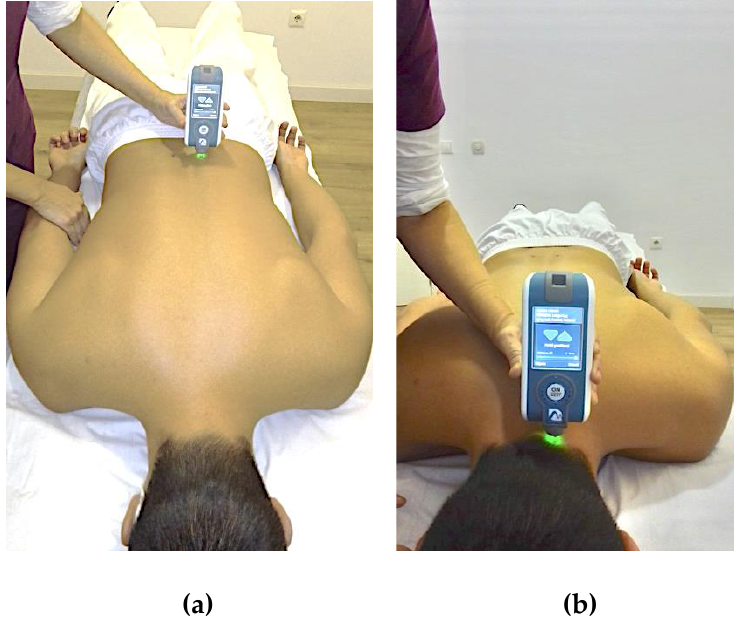
Figure 1. Assessment of muscle mechanical properties (MMPs). ( a ) Lumbar myotonometry. Subject position and device location. ( b ) Cervical myotonometry. Subject position and device location.